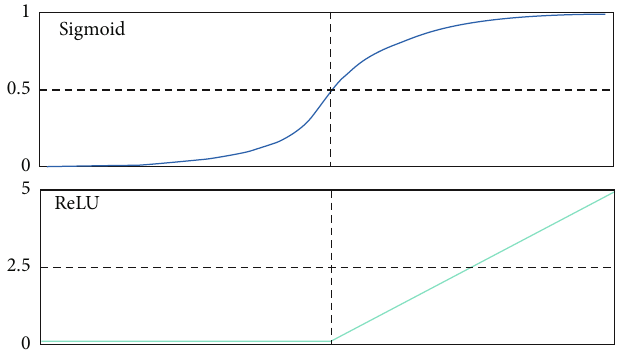
Figure 3: Schematic diagram of Sigmoid function and ReLU function.